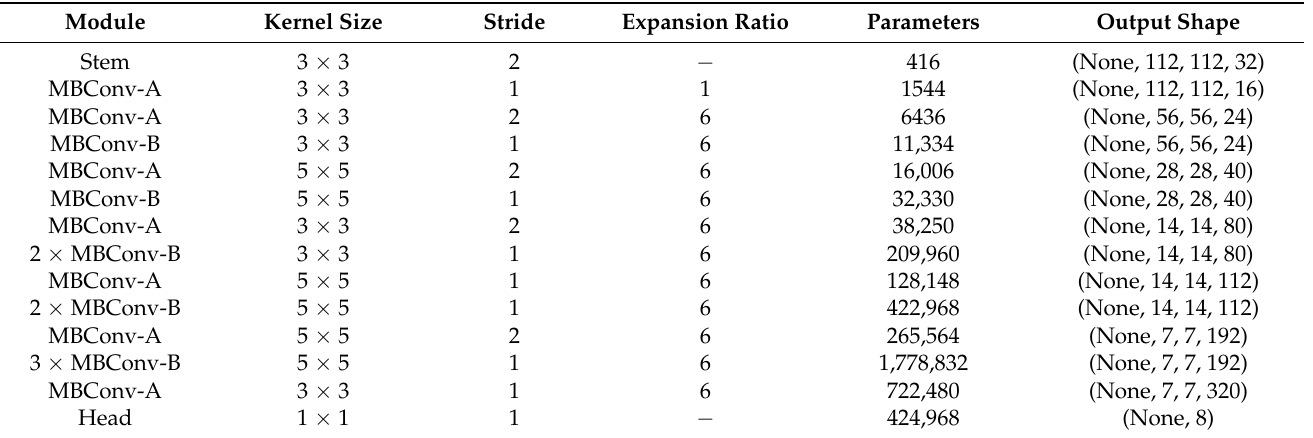
Table 4. Summary of each module in the presented